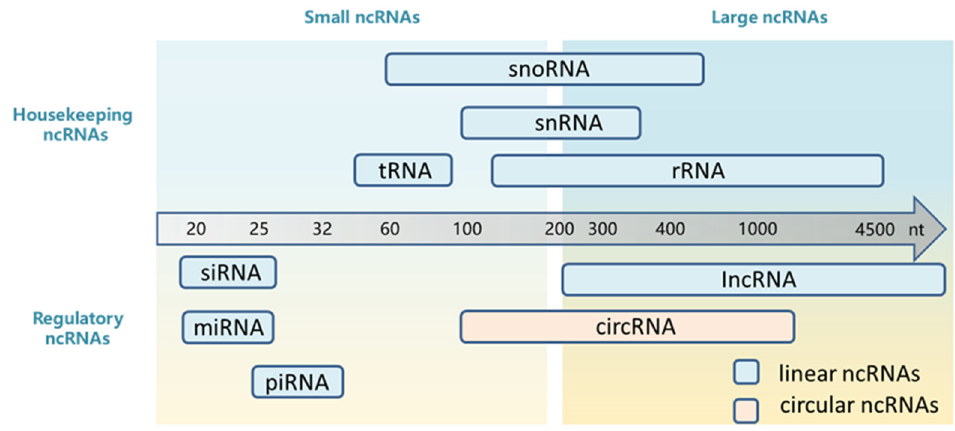
Figure 1. Classification and molecular size of ncRNAs.